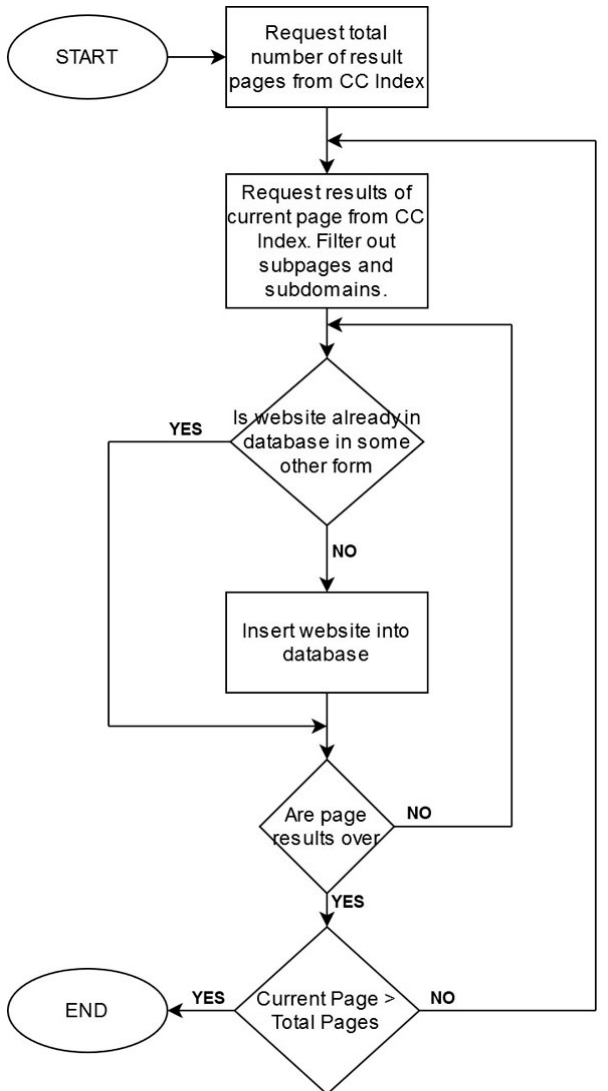
Figure 1. Flowchart of the website collection process.